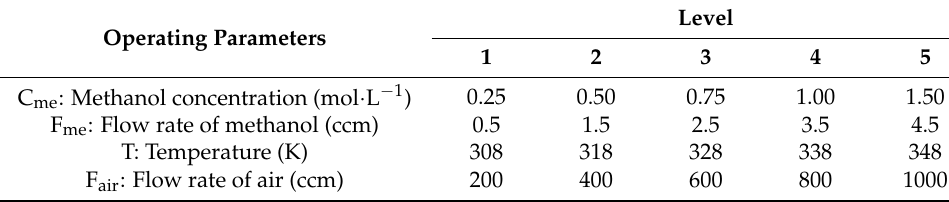
Table 1. Operating parameters and five levels of these operating parameters.